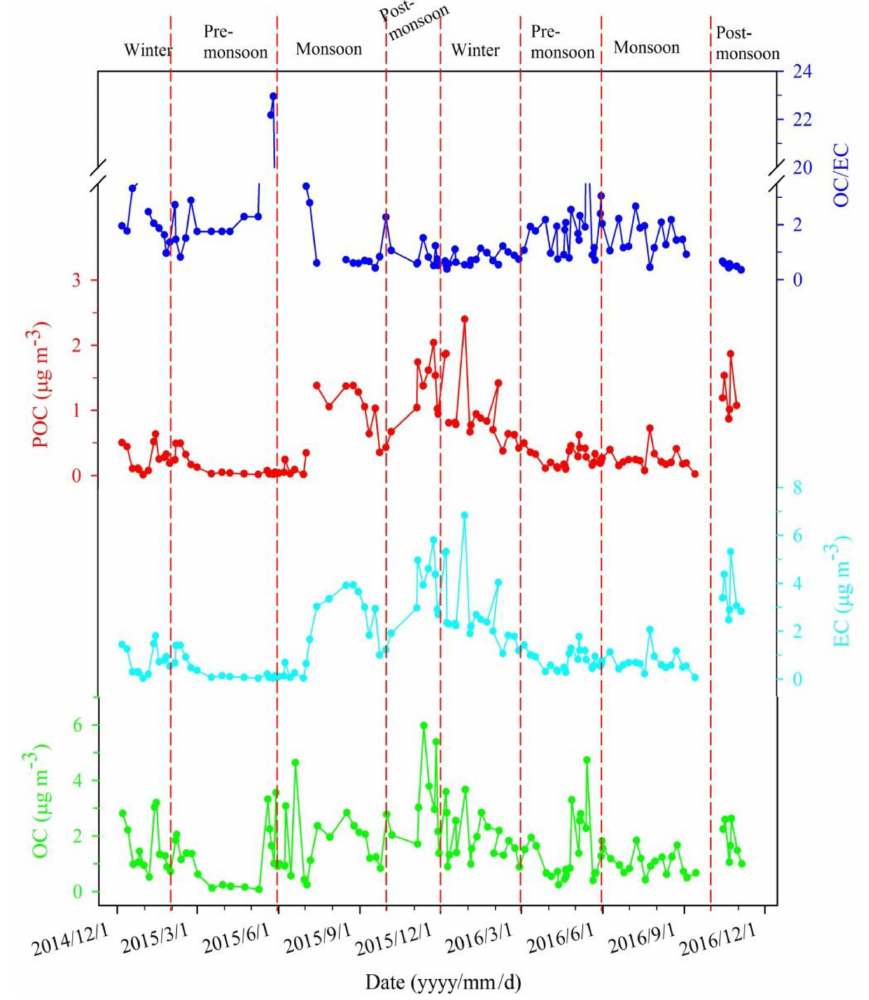
Figure 4. Seasonal variations of EC, OC, and POC concentrations and the OC / EC ratio from Mt. Yulong during December 2014–December